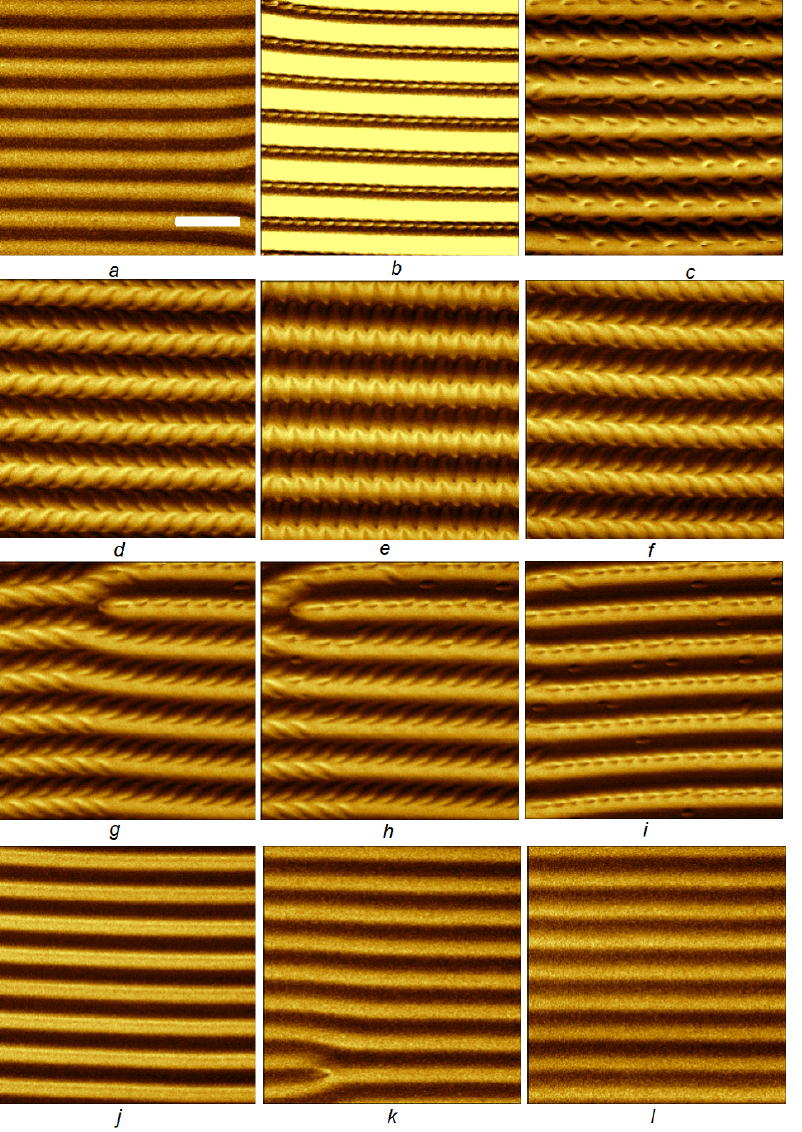
Figure 2. MFM images of the garnet film in the in-plane magnetic field. The film was initially saturated. ( a ) H = − 387 Oe, ( b ) H = − 235 Oe, ( c ) H = − 142 Oe, ( d ) H = − 65 Oe, ( e ) H = 0 Oe, ( f ) H = 65 Oe, ( g ) H = 176 Oe, ( h ) H = 178 Oe, ( i ) H = 192 Oe, ( j ) H = 300 Oe, ( k ) H = 394 Oe, ( l ) H = 410 Oe. The scale bar corresponds to 5 µ